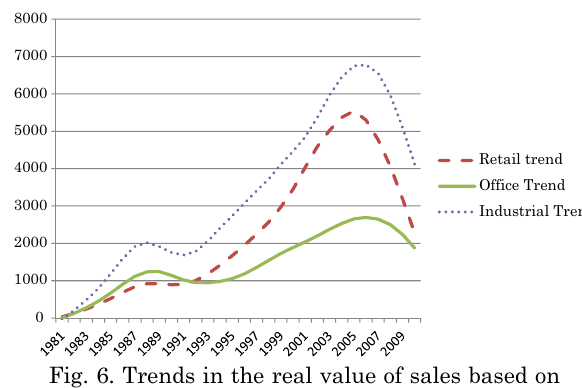
fig. 3. Indices of the annual real value of purchases by property sector 1981–2010